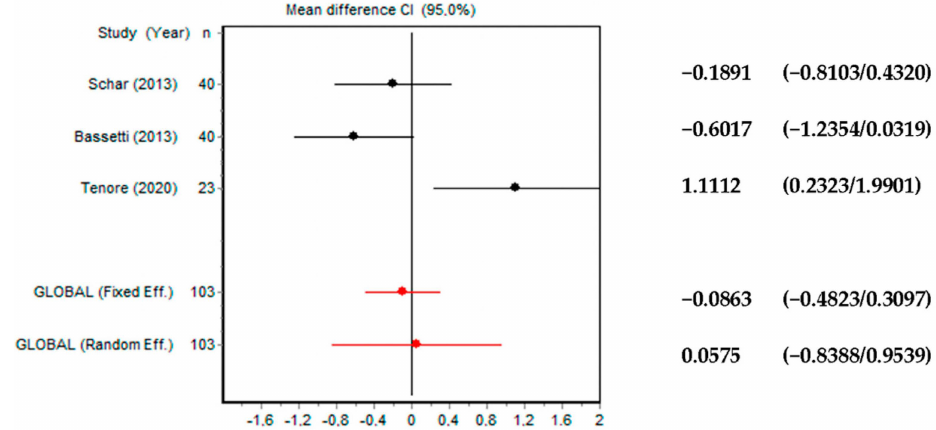
Figure 4. Forest plot for PPD reduction mean (diode laser vs. conventional mechanical therapy).